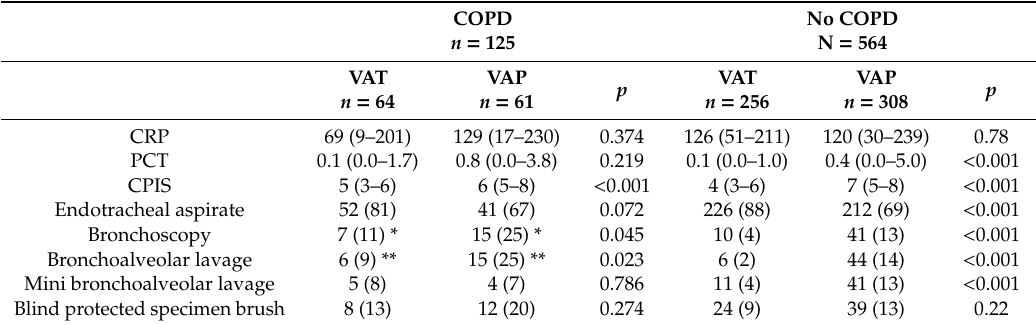
Table 2. Biological criteria and microbiological diagnostic procedures used in ventilator-associated lower respiratory tract infection diagnosis in COPD and non-COPD patients.